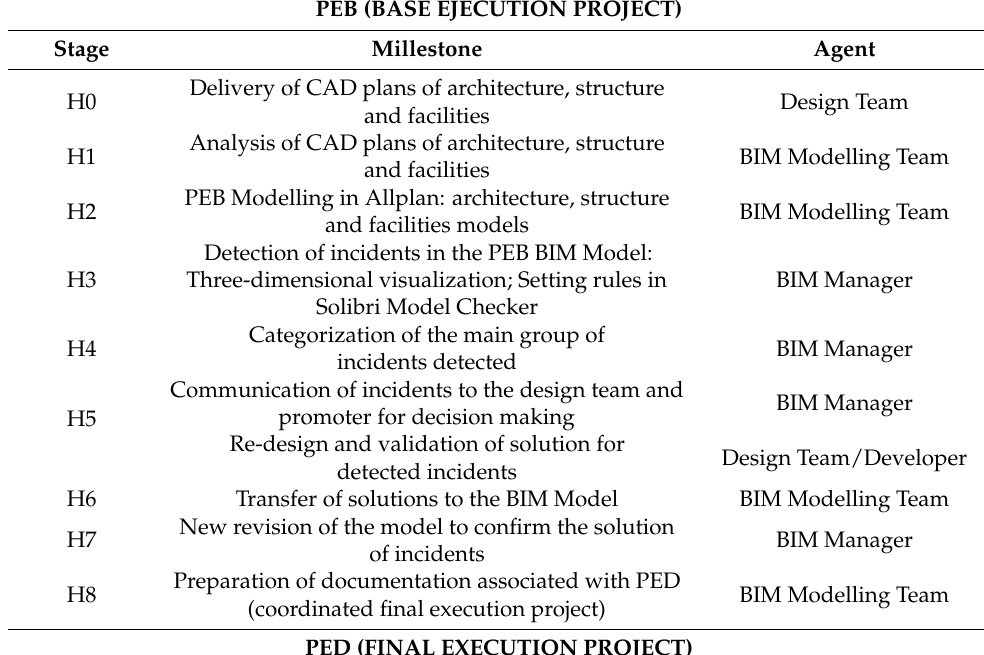
Table 2. Schedule of work process to be